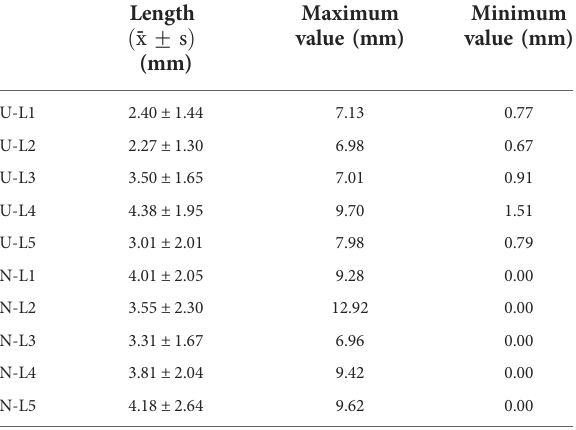
TABLE 1 Safety measurement of needle entry point.